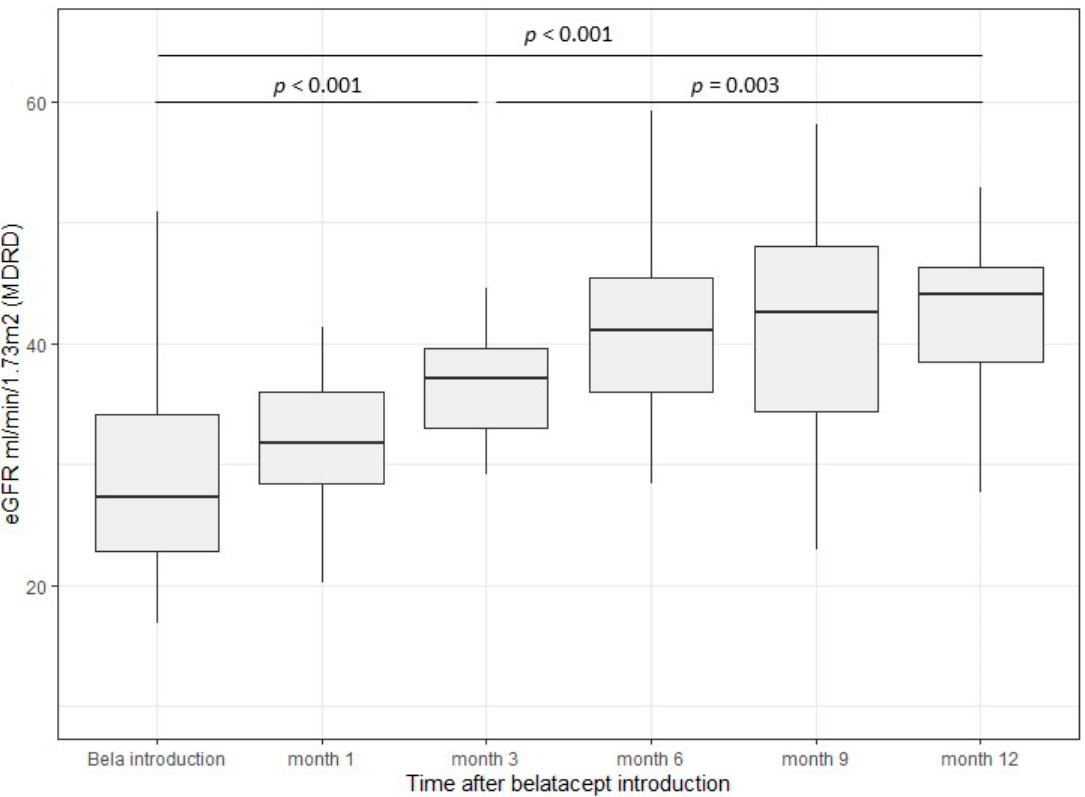
Figure 2. Effect of belatacept introduction/CNIs withdrawal on eGFR ( n = 28).